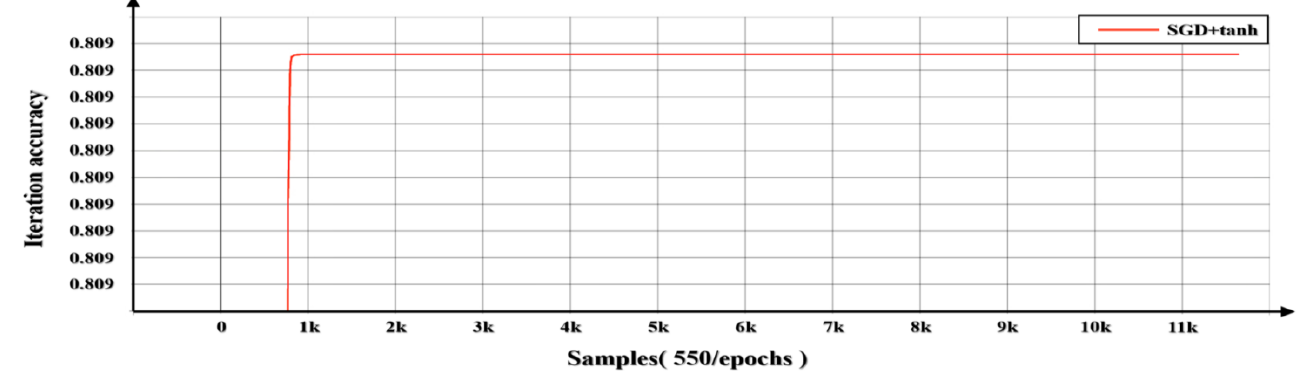
Figure 10. The precision curve of SGD+tanh solution method.